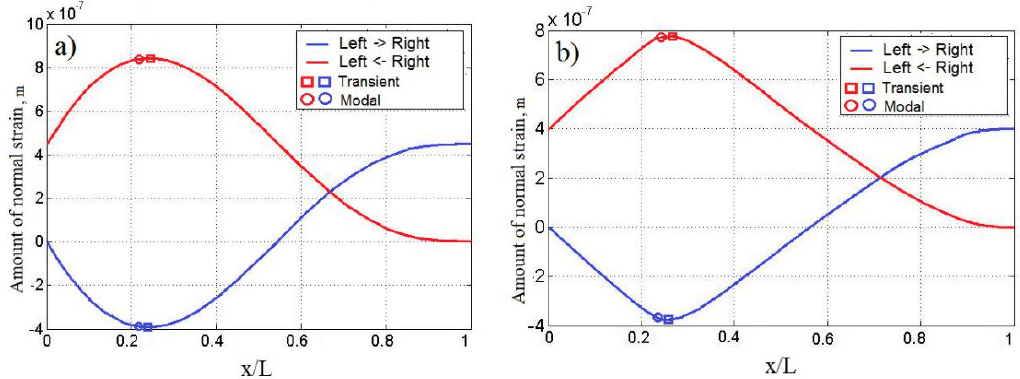
Figure 9. Accumulation of normal strain over length x/L per ½ T : ( a ) cantilever of a constant cross-section; ( b ) optimally-shaped cantilever. The blue curve represents the integration from the fixed end to the free end of the cantilever, red the integration of the opposite direction. Table 3. Comparison of normal strain amount.